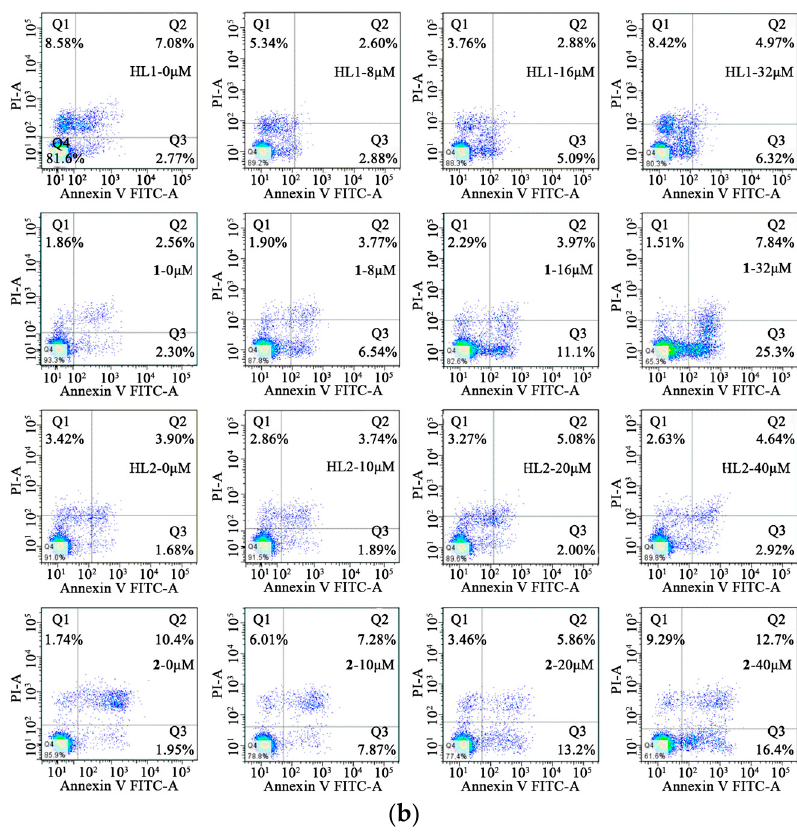
Figure 7. Cell apoptosis. ( a ) Effects of HL1, HL2, 1 and 2 on the cell early apoptosis of HepG2 cells after incubation for 24 h; ( b ) Effects of HL1, HL2, 1 and 2 on the cell early apoptosis of MGC80-3 cells after incubation for 24 h.